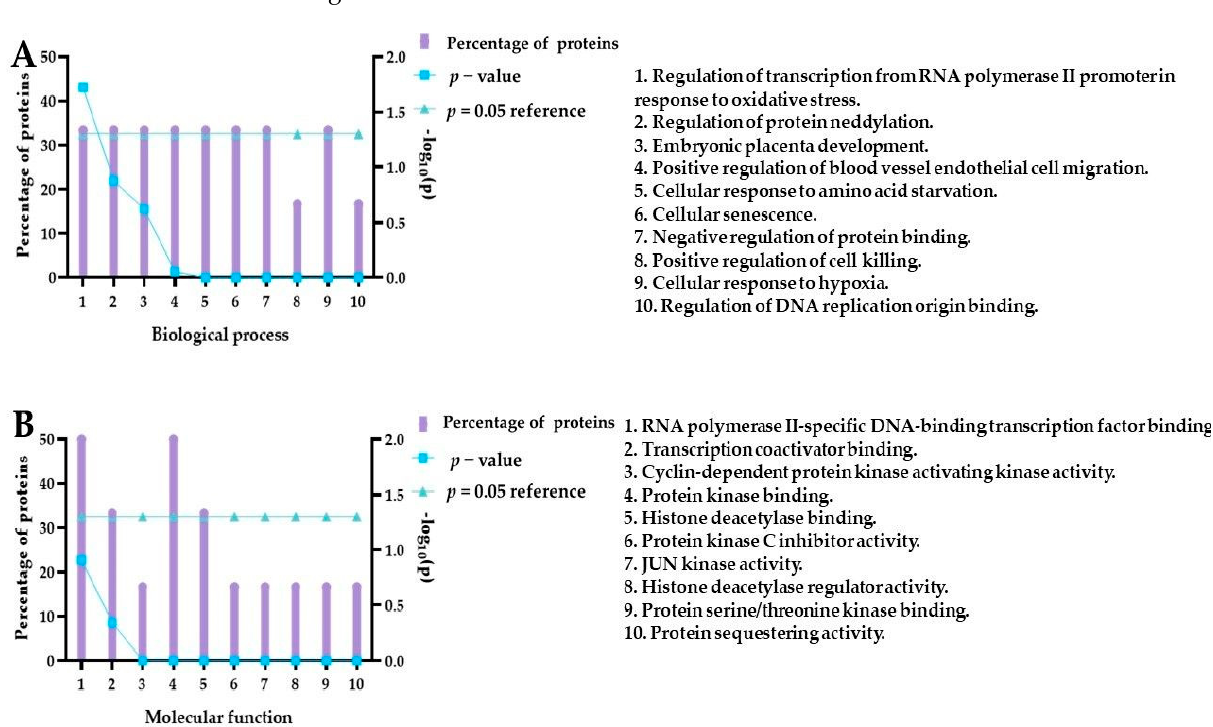
Figure 15. Enriched biological process and molecular function of proteins overexpressed after treatment with compound 5 under hypoxic conditions. The FunRich software further analyzed the six proteins (HIF-1 α , HIF-2 α , ADAMTS-1, phospho-JNK, p21, and phospho-HSP27) upregulated by compound 5 for pathway enrichment, e.g., biological process (panel A ) and molecular function (panel B ). The graph presents the top 10 enriched biological processes and molecular functions.